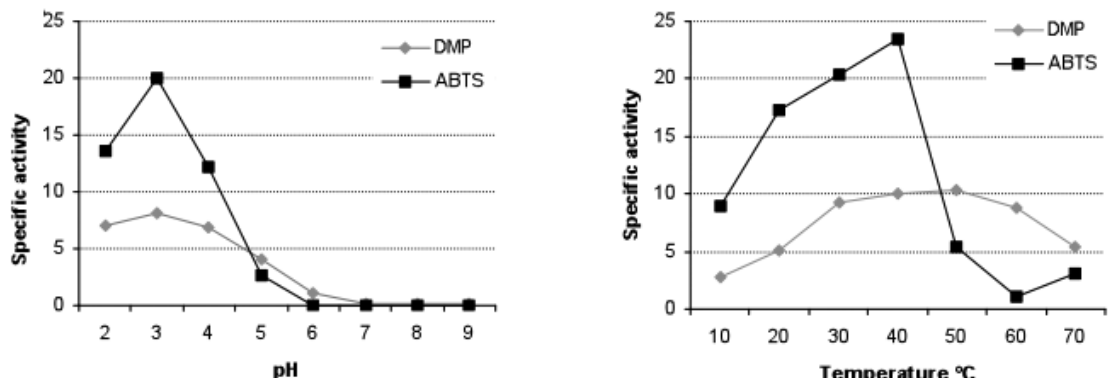
Figure 4. pH A, and B, temperature activity profiles of purified laccase from Fomitiporia mediterranea.